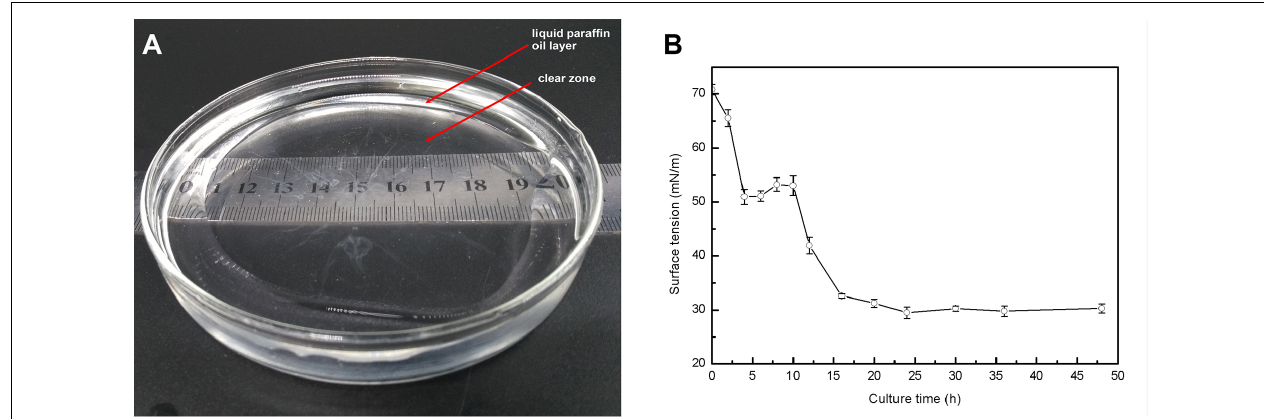
FIGURE 3 | Production of biosurfactant by P . aeruginosa L10. (A) Oil displacement induced by the fermentation broth of a 48-h-old culture of strain L10 was measured using the oil spreading technique. (B) Surface tension of the fermentation broth as a function of time. Error bars indicate the standard deviations of three